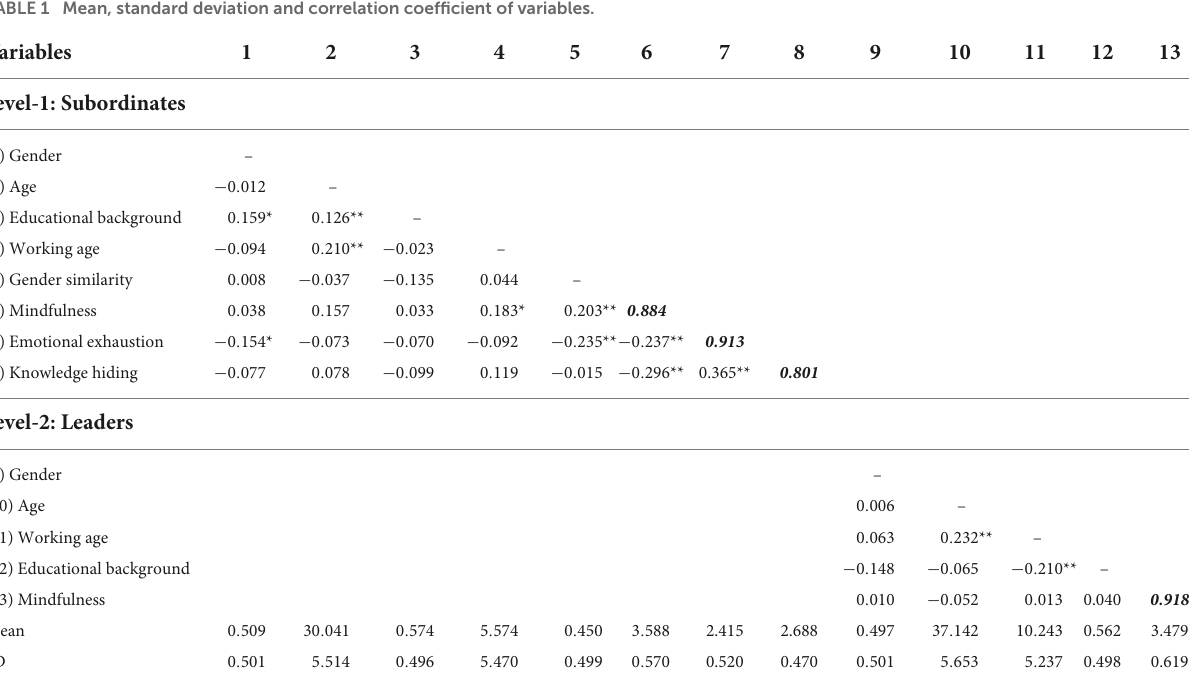
TABLE 1 Mean, standard deviation and correlation coefficient of variables.